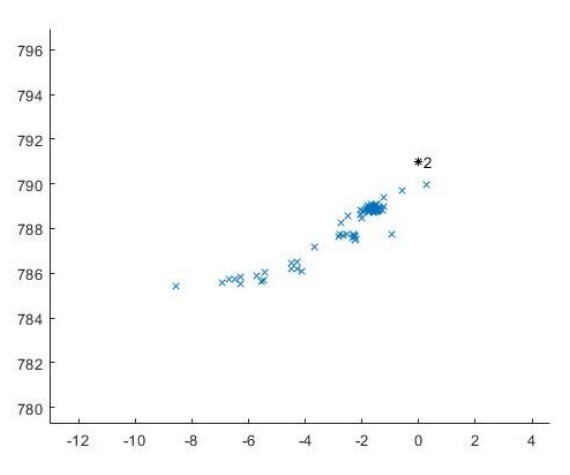
Figure 2: Point 2 lowest RMSE local